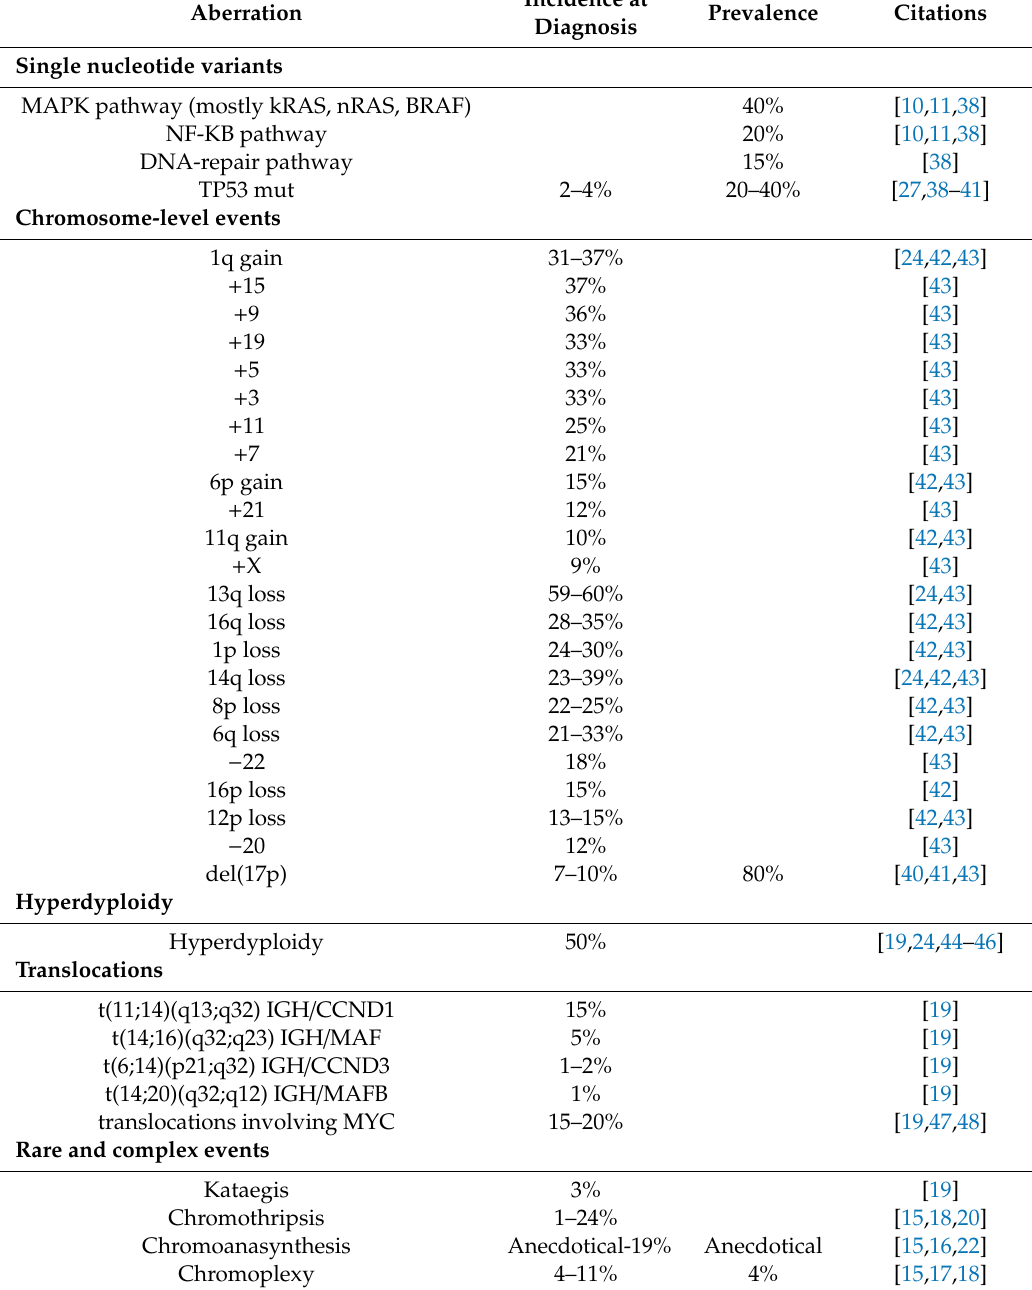
Table 1. List of aberration deriving from genome or DNA damage in multiple myeloma, sorted by incidence or prevalence. Some digits may vary from original studies due to